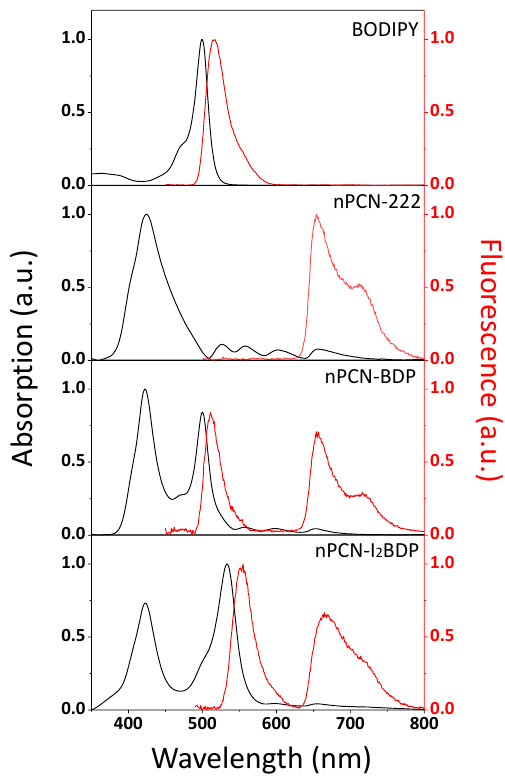
Figure 2. Absorption and fluorescence emission spectra of BODIPY, nPCN-222, nPCN-BDP and nPCN-I 2 BDP dispersed in acetone.